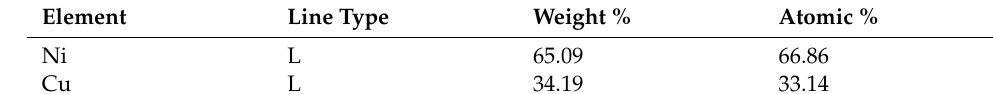
Table 2. All the element contents of the copper nickel alloy.